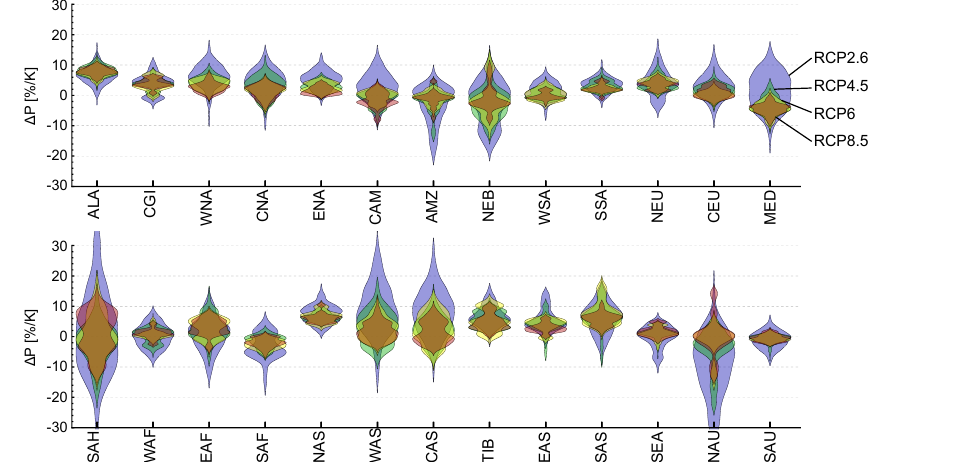
Figure 7. Uncertainty distributions (shown as violin plots) of the sensitivity of P to global mean temperature change for each emission scenario averaged over all SREX regions (as outlined in Table 2 and Fig. 3).